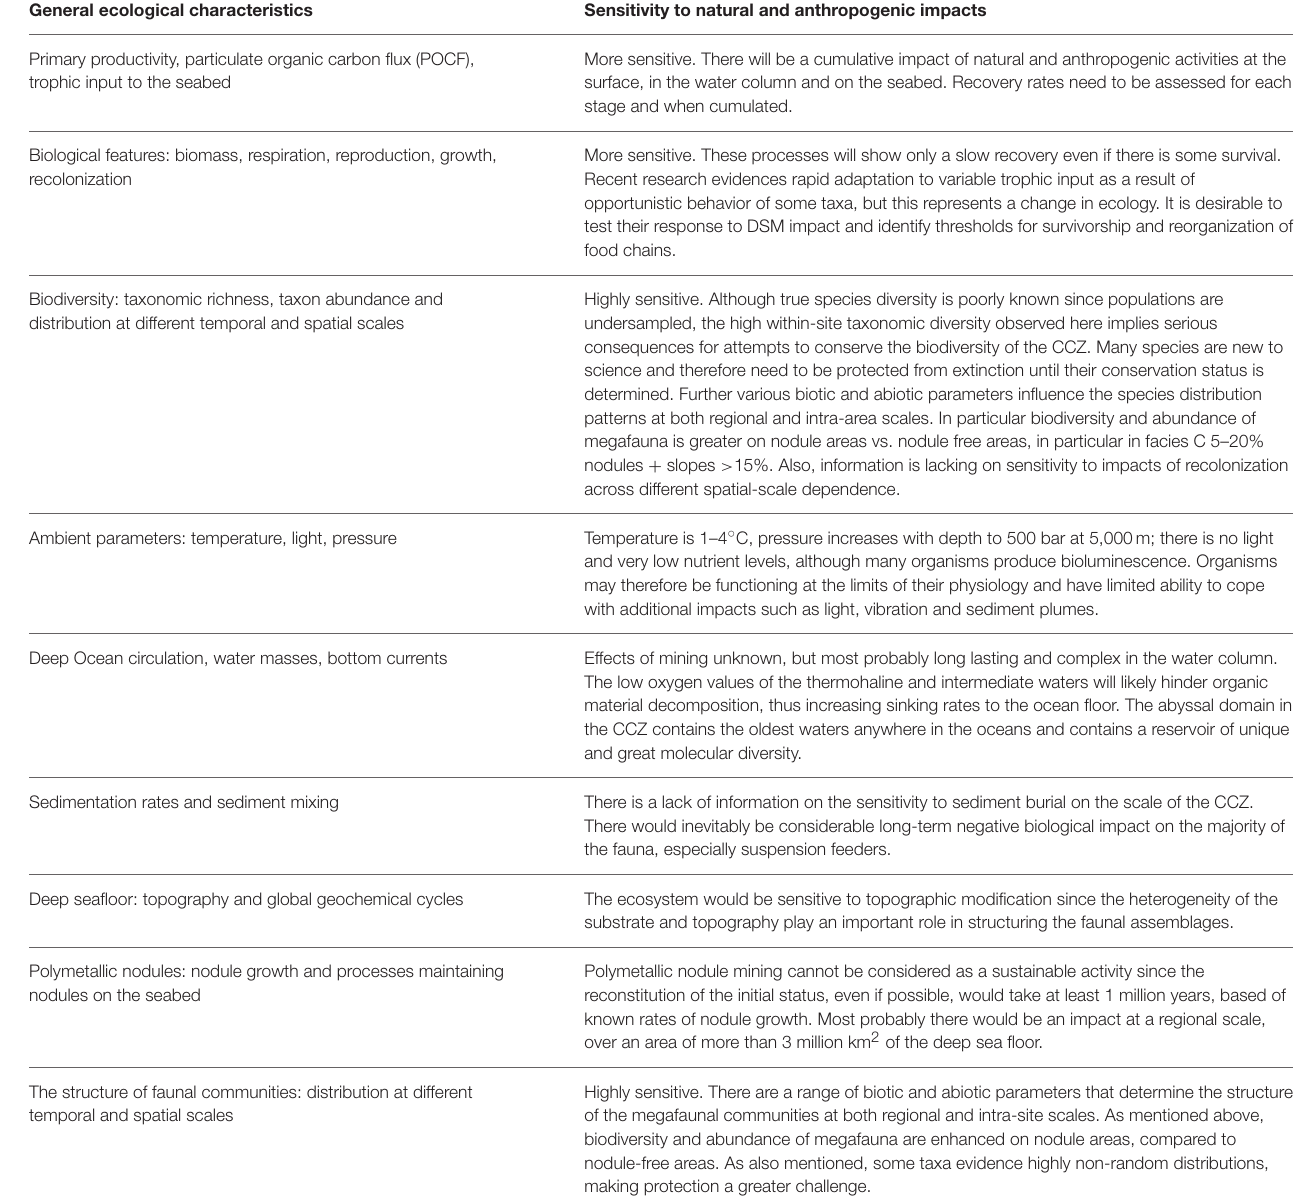
TABLE 4 | Table summarizing the potential effects of nodule exploitation on all aspects of the environment and ecology of the CCZ. General ecological characteristics Sensitivity to natural and anthropogenic